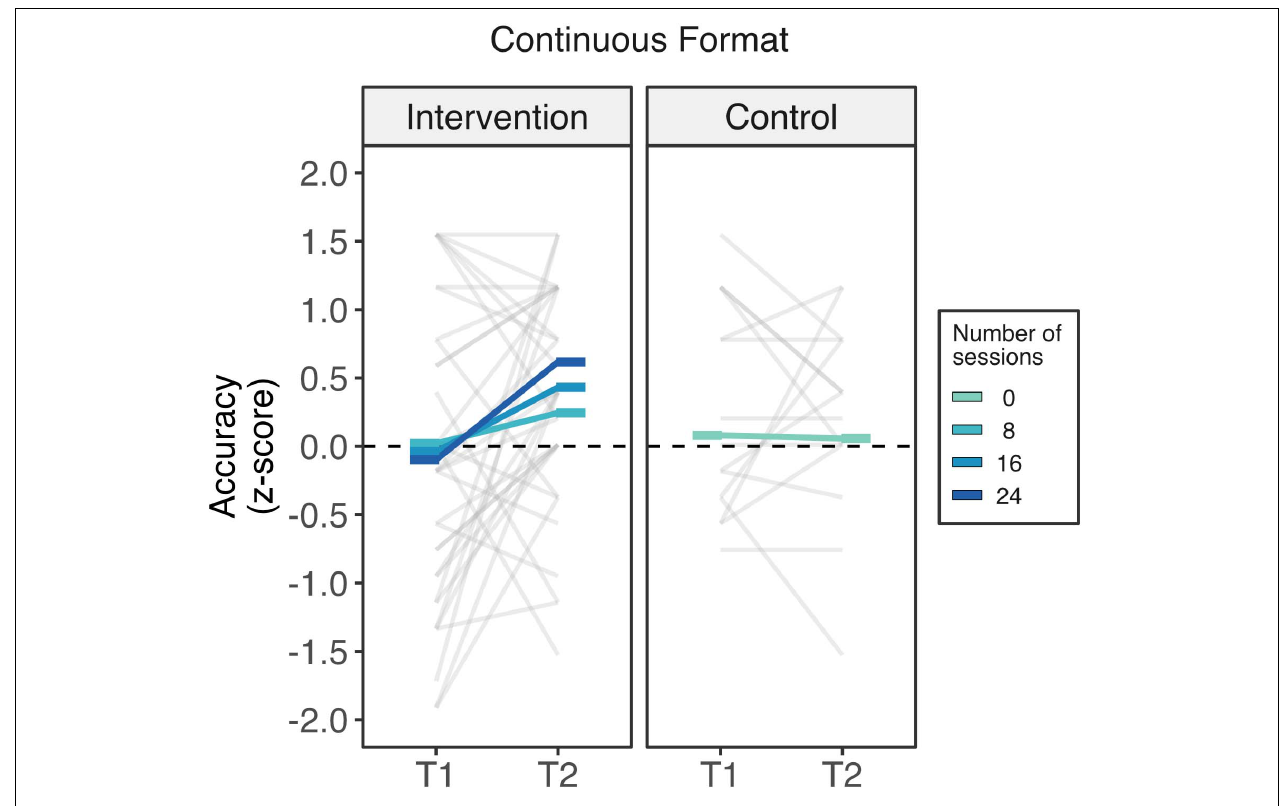
FIGURE 3 | Intervention outcomes in the non-symbolic continuous format of the Spinners task by the number of completed sessions. Children who attended all the sessions of the Cuisenaire intervention showed a reliable increase in their ability to compare spinners presented in the continuous format while children were part of the control group showed exhibited no improvement. Rods represents the estimated marginal means across different number of sessions of attendance from 0 sessions (control group) to 24 sessions (darkest